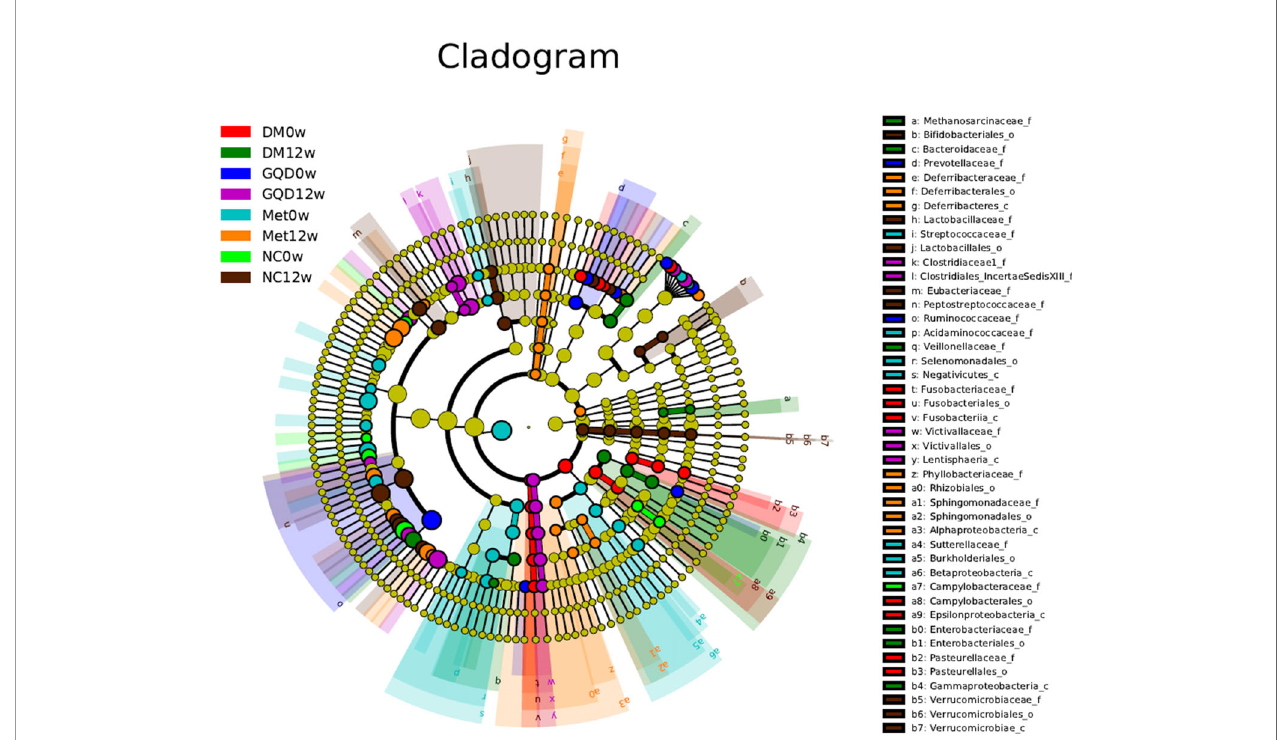
FIGURE 5 | Taxonomic differences of gut microbiota among different groups. Taxonomic cladogram obtained by LEfSe before and after treatments. Differences are represented by the color of the most abundant class. The diameter of each circle is proportional to the taxon ’ s abundance.